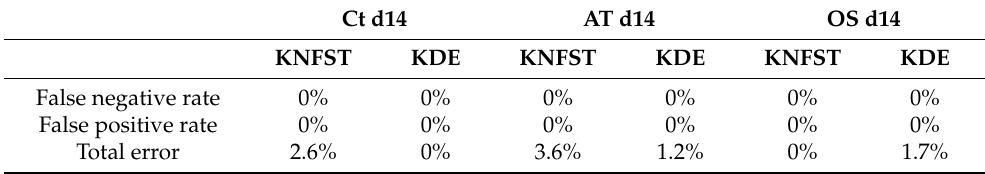
Table 2. A summary of the performance of KDE and KNFST classifiers for Ct d14, AT d14 and OS